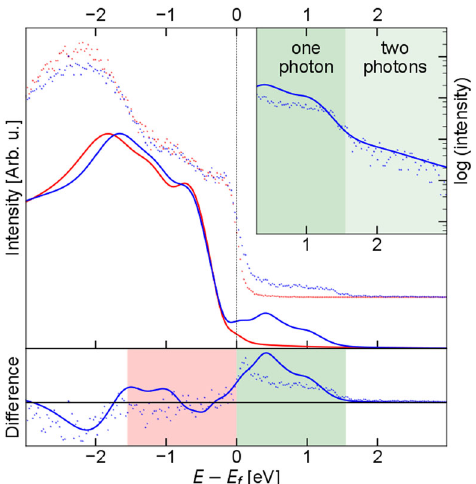
Fig. 3 Comparison of experimental and computed photoelectron spectra of FeRh. Experimental spectra (dots) at equilibrium ( t = − 0.5 ps, red) and at the maximum of the pump pulse ( t = 0 ps, blue) are compared in linear (top panel) and logarithmic scales (inset) to the TD-DFT calculations (solid lines) of the electronic structure of FeRh in the AFM phase (red) and at laser excitation (blue). The bottom panel displays the difference between the corresponding experimental and theoretical spectra in the top panel. The green (red) region represents the energy range to (from) which electrons are excited with one-photon (1.55 eV) processes. The light green region in the top panel inset identi fi es the energy range that can be reached by two-photon (3.1 eV) processes.